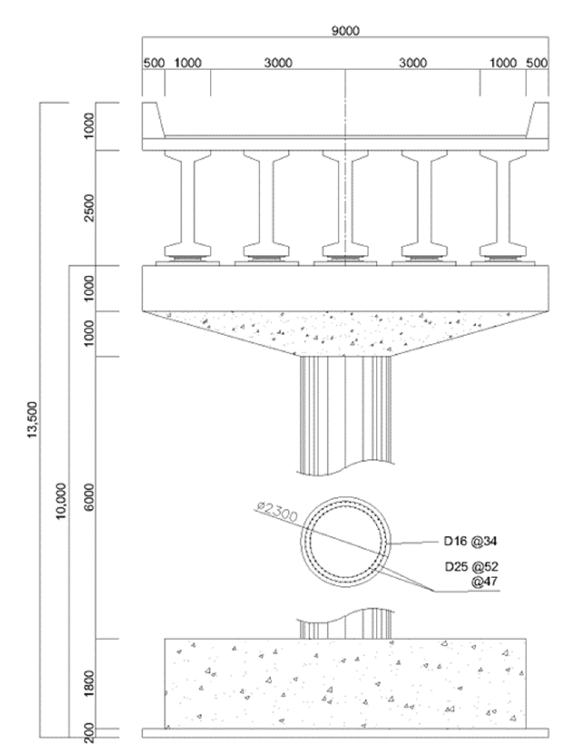
Figure 4. Cross section of the bridge and pier.